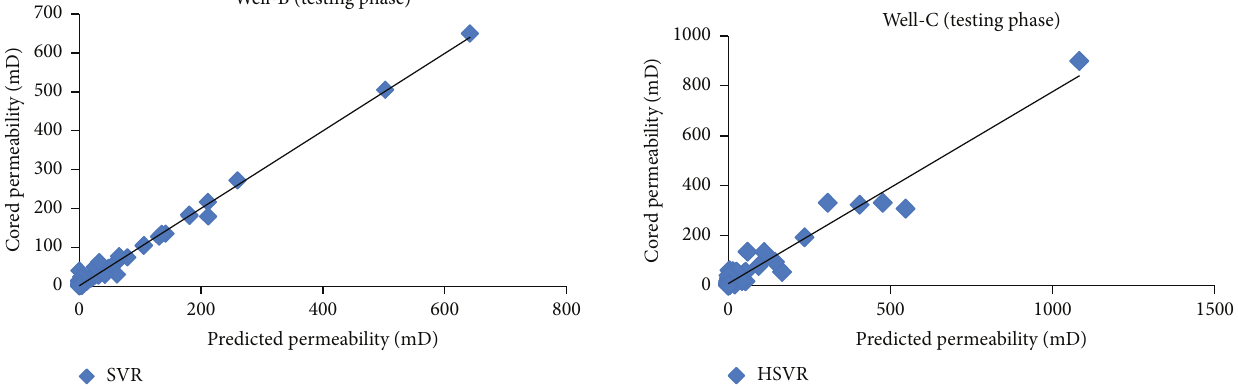
Figure 17: Cross plot of cored and predicted permeability for HSVR